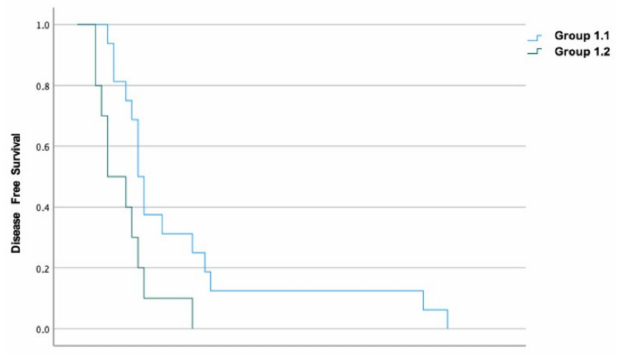
Figure 2. Kaplan–Meier curves for DFS in groups 1.1 and